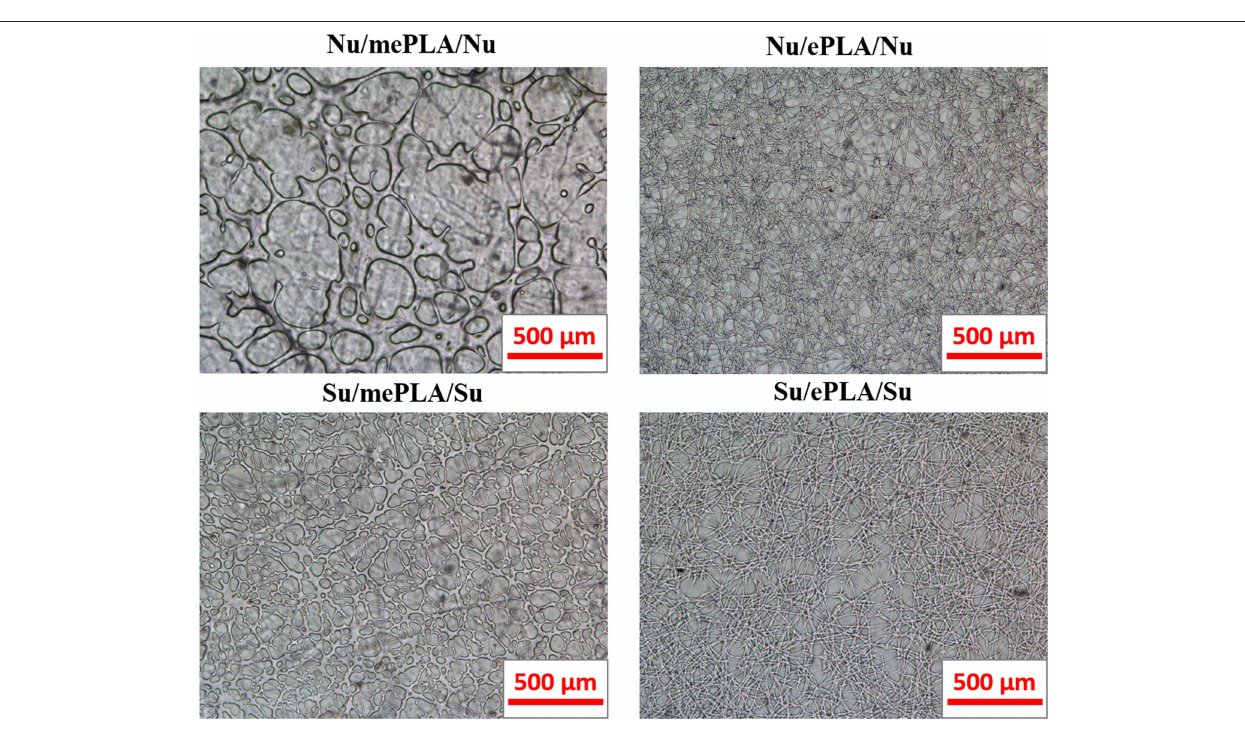
Frontiers in Materials |